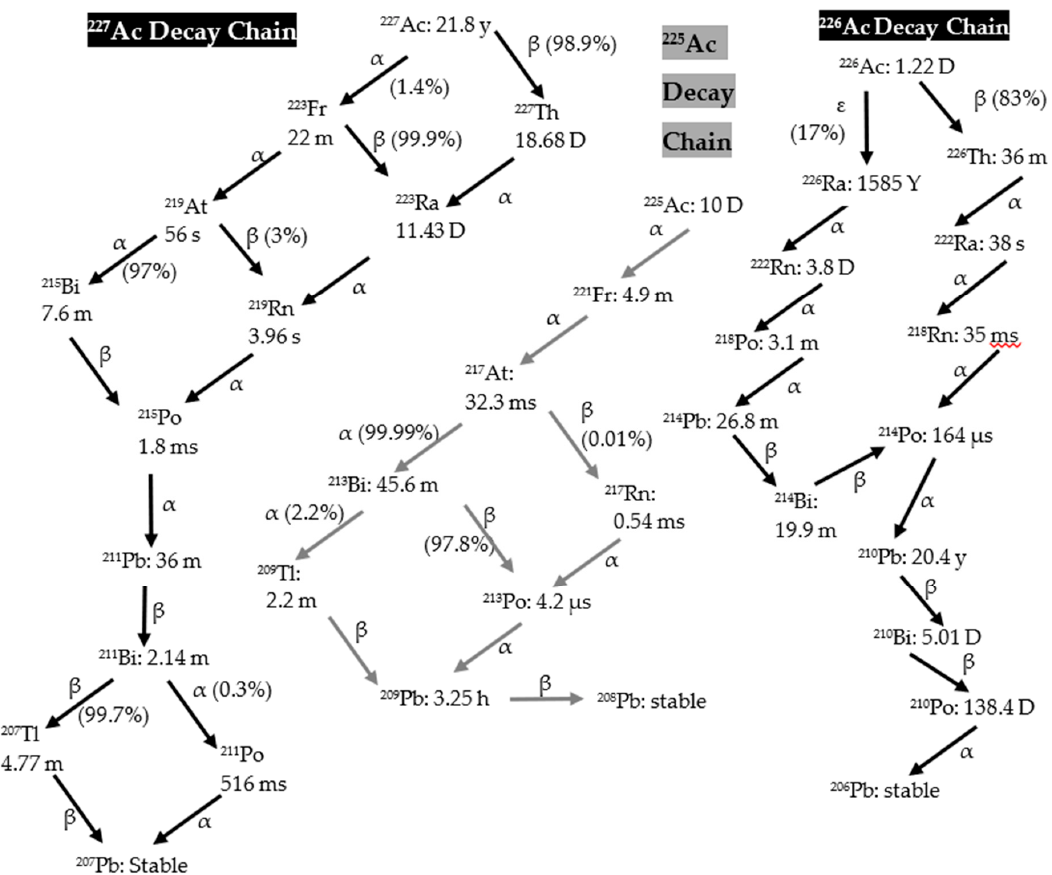
Figure 6. Ac-225, Ac-226, and Ac-227 decay chains [18].